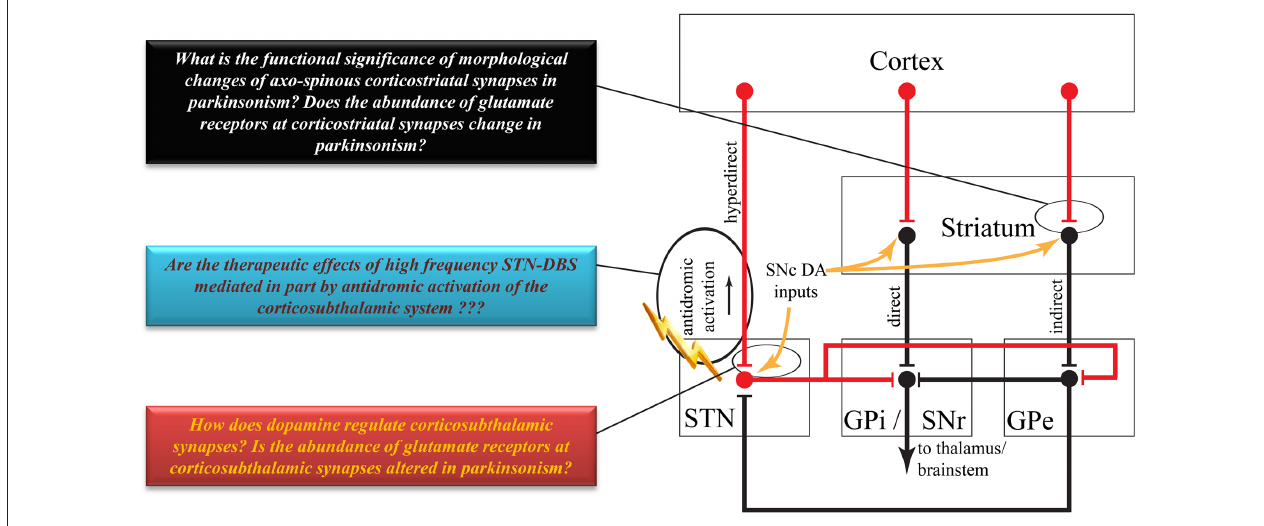
sake of simplicity. Colored boxes highlight some key issues to be addressed about the anatomy and function of the corticostriatal and corticosubthalamic systems. See text